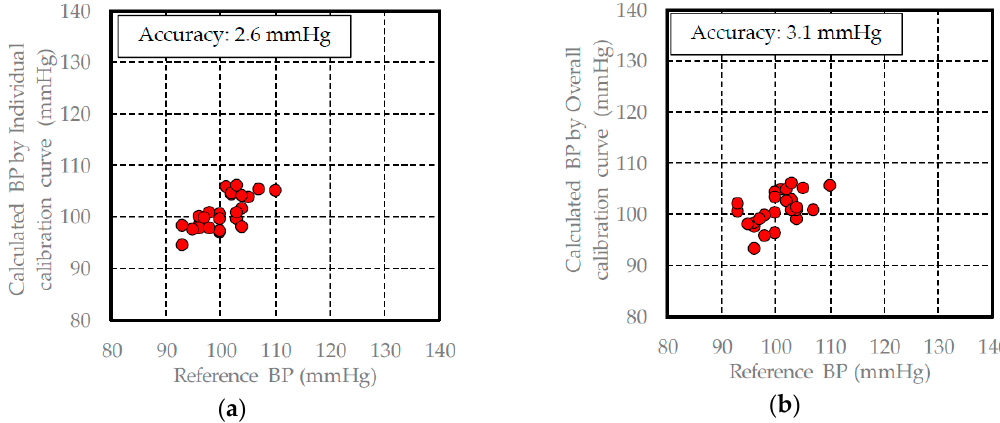
Figure 10. Validation results of the blood pressure in subject C: ( a ) calculated blood pressure results using the individual calibration curve; ( b ) calculated blood pressure results using the overall calibration curve.